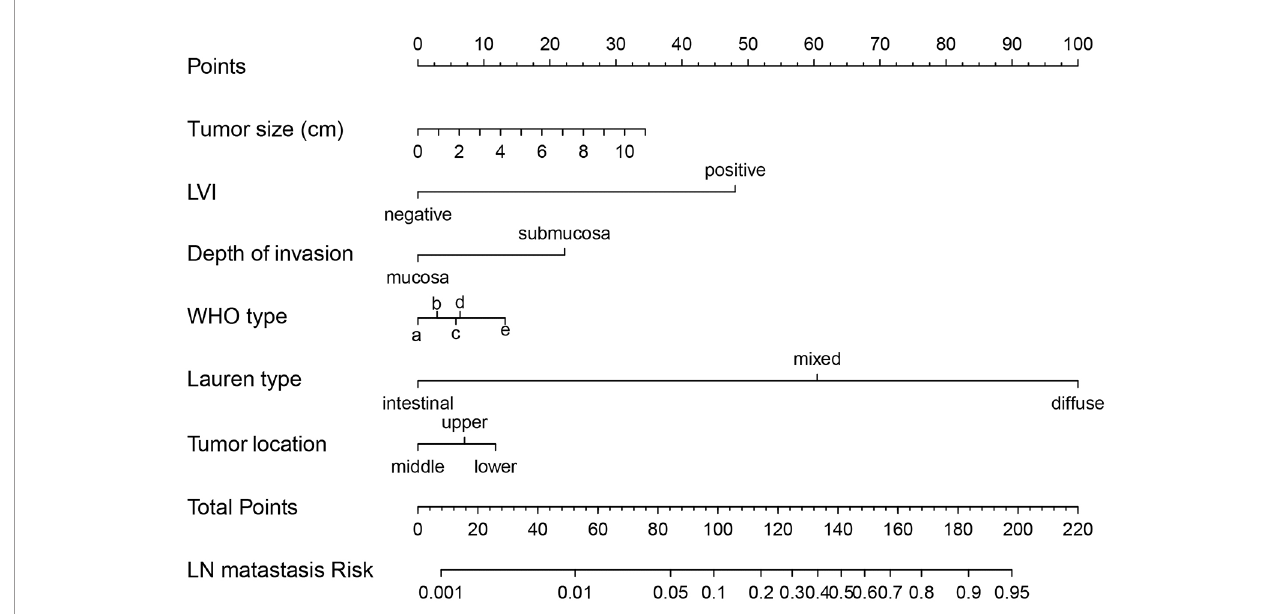
FIGURE 4 | Nomogram prediction model for LN metastasis in male EGC patients. LN, lymph node; EGC, early gastric cancer; LVI, lymphovascular invasion; WHO types: (a) polypoid adenocarcinoma; (b) tubular adenocarcinoma; (c) poorly differentiated; (d) mucinous adenocarcinoma; (e) signet-ring cell